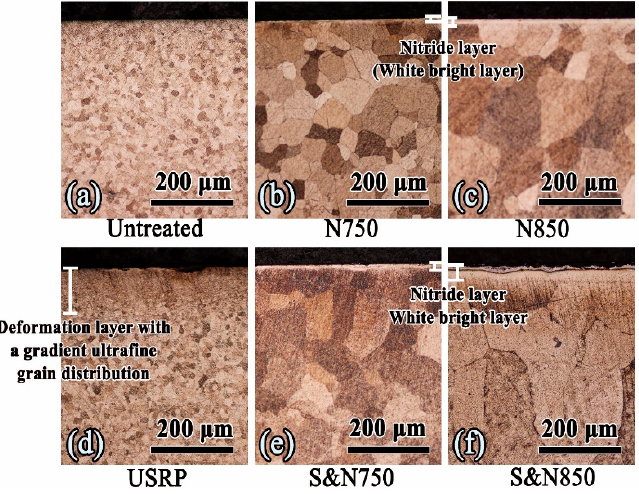
Figure 4. 3D profiler images of the ( a ) Un-treated, ( b ) N750, ( c ) N850, ( d ) USRP, ( e ) S&N750 and ( f ) S&N850 Ti.